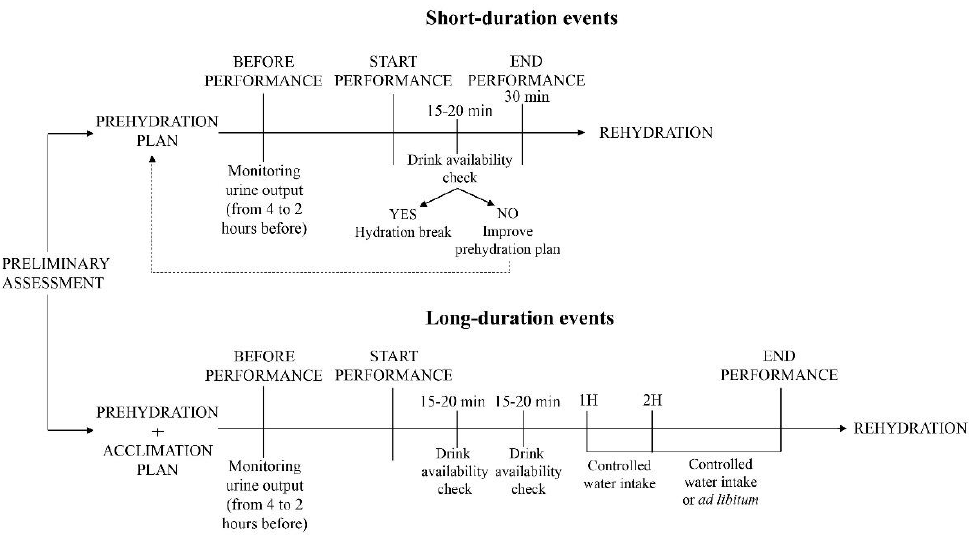
Figure 2. Timelines of hydration status in short- and long-duration events.